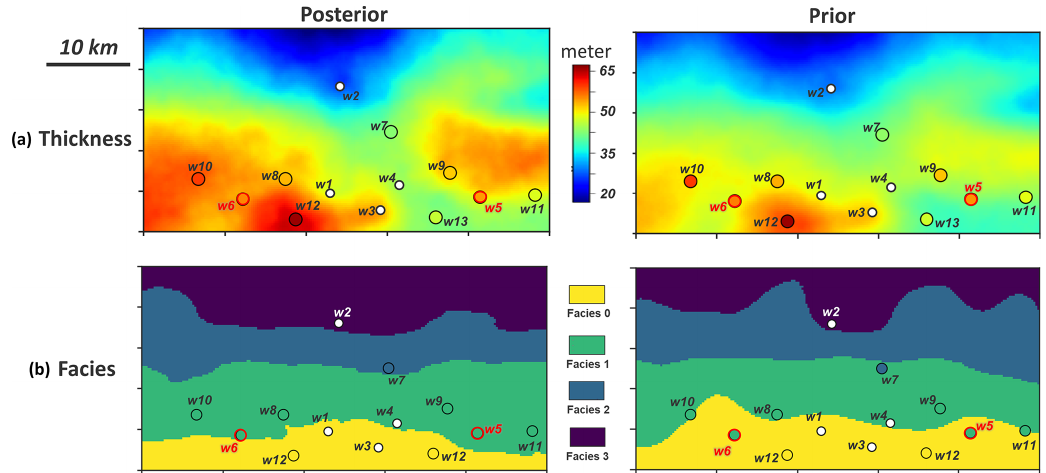
Figure 12. (a) Ensemble mean of posterior and prior thickness. (b) The median realization of posterior and prior facies. The dots are borehole locations and their color represents the actual borehole observation values. The boreholes and models share the same color